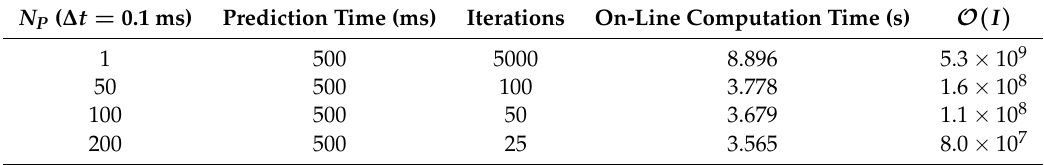
Table 1. Comparison of computational requirement for the iterative approach presented in this paper. N P ( ∆ t = 0.1